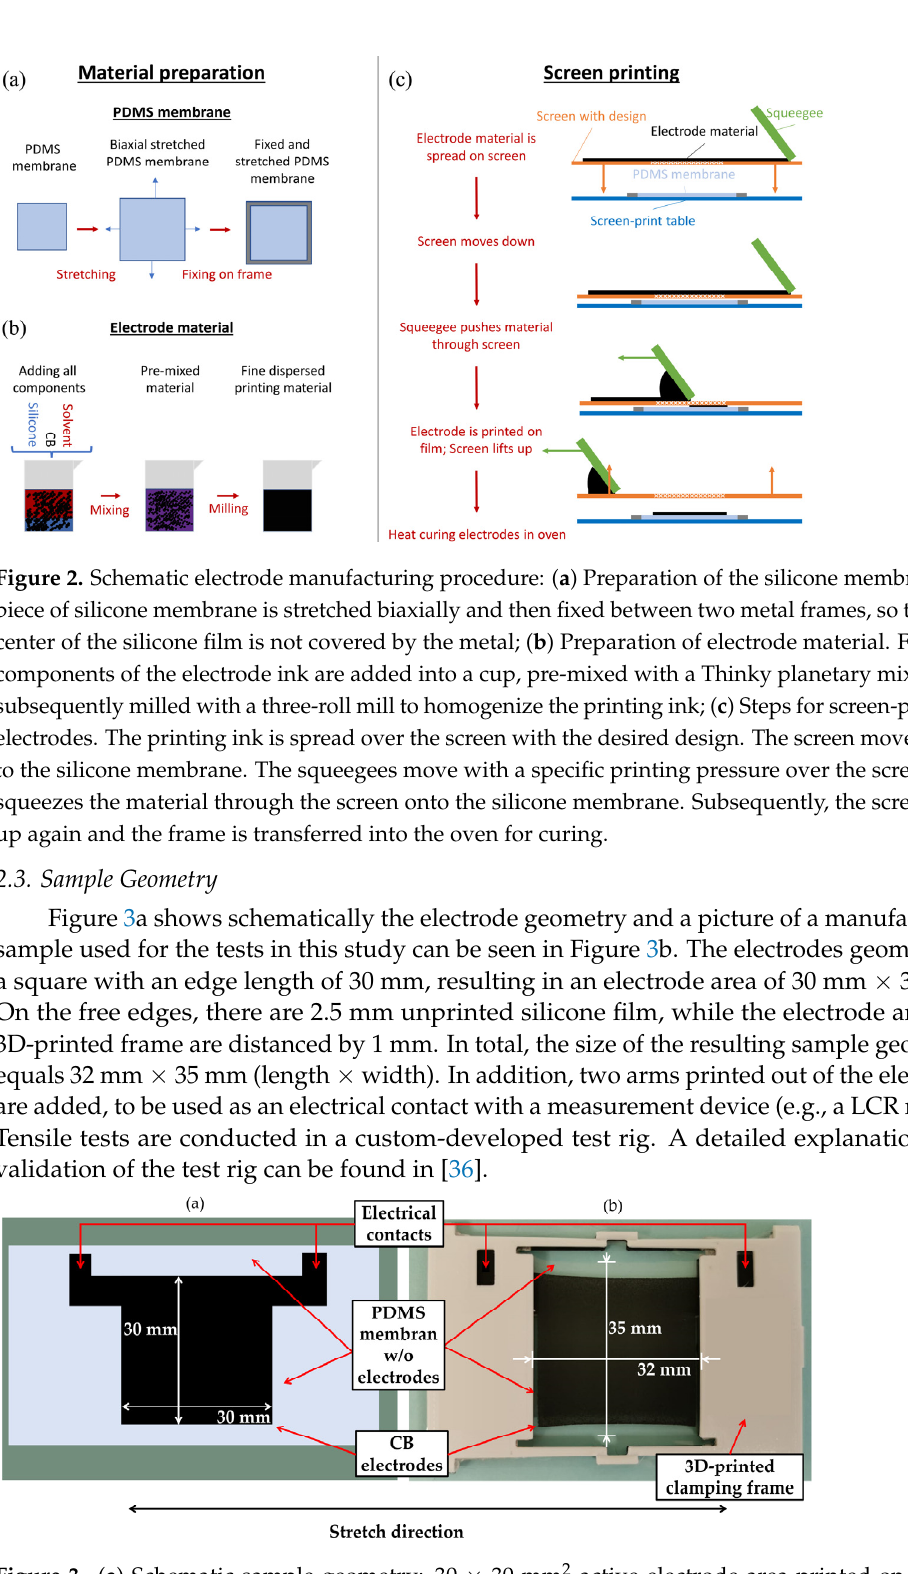
Figure 3. ( a ) Schematic sample geometry: 30 × 30 mm 2 active electrode area printed on PDMS membrane. Arms are printed on both sides for electrical connection to the test rig. Arms are clamped in between a 3D-printed clamping frame and are not stretched during the measurements.; ( b ) actual sample inside 3D-printed clamp for testing in the universal test rig. The overall sample geometry is 32 mm × 35 mm, as there are 2.5 mm unprinted PDMS membrane on the free sides (top and bottom) and 1 mm unprinted PDMS membrane on both sides between the active electrode area and 3D-printed clamping